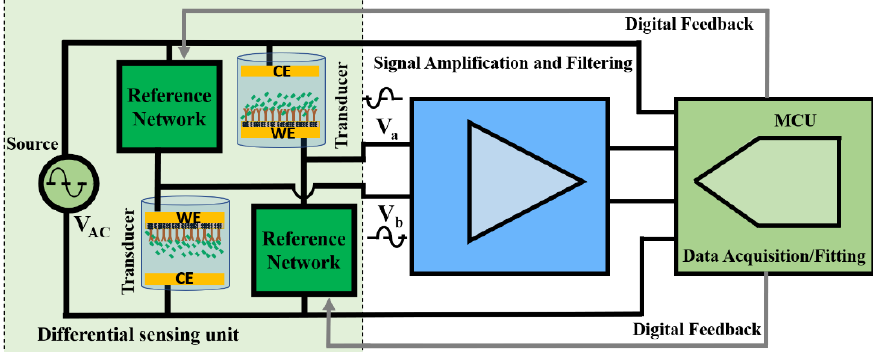
Figure 1. General block diagram of a differential bio-sensing unit interfaced with signal amplification and filtering unit and a microcontroller (MCU) for low-cost real-time operation and field deployment. The transducers are designed to sense the change in the transducer impedance due to bio-recognition with respect to the reference networks differentially. Amplification/filtering is typically required with the expected weak and noisy sensor response. For real-time and low-cost operation, an MCU performs both the task of data acquisition and processing (fitting) and any extra required digital adjustments.